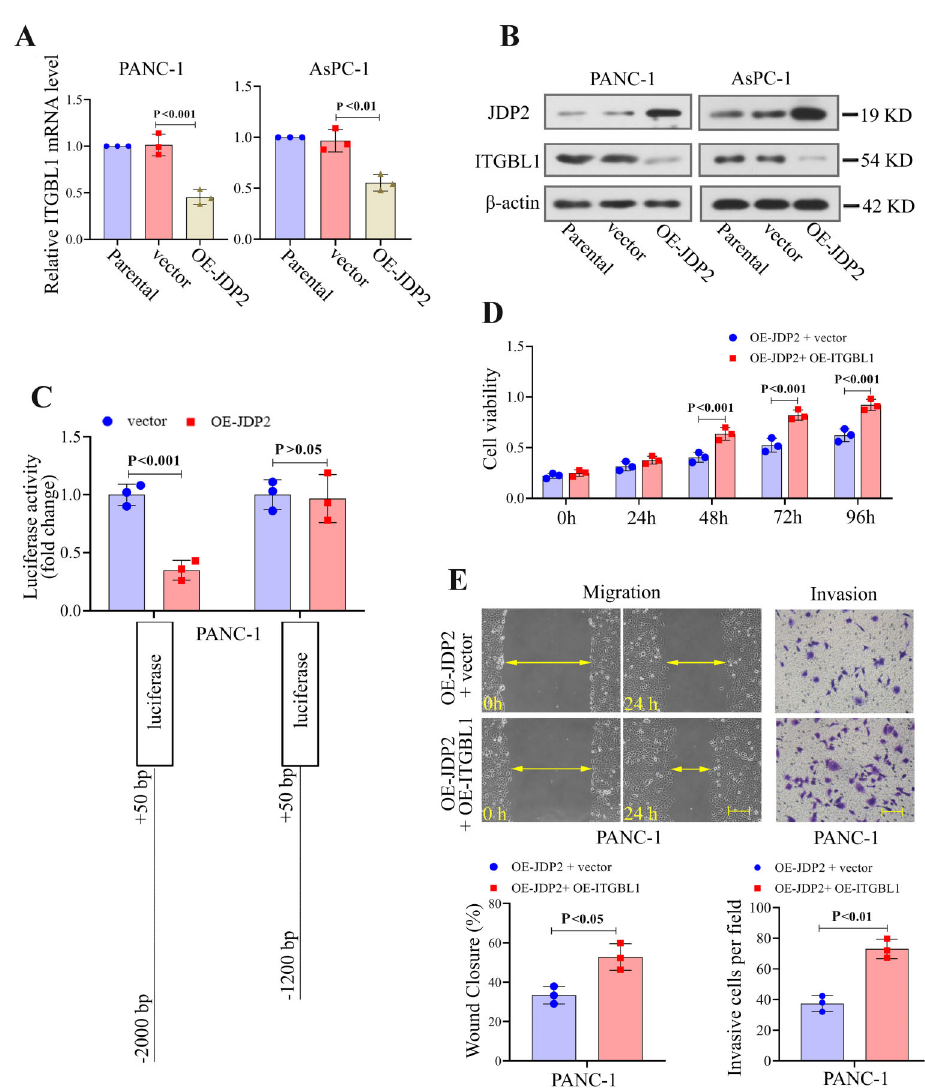
Figure 6. ITGBL1 was transcriptionally inhibited by JDP2 in pancreatic cancer cells and mediated the effects of JDP2 overexpression (OE). A, ITGBL1 mRNA levels in JDP2-overexpressed cells were measured by real-time quantitative PCR. B, JDP2 and ITGBL1 protein levels in pancreatic cancer cells with JDP2 overexpression were measured by western blot. C, Luciferase activity was detected after PANC-1 cells were co-transfected with a luciferase reporter vector and JDP2 overexpression vector or empty vector. D and E , Cell viability, migration (Scale bar=200 m m), and invasion (Scale bar=100 m m) of JDP2-overexpressed cells transfected with ITGBL1 overexpression vector or empty vector were measured. Data are reported as means ± SD for N=3 (ANOVA and t